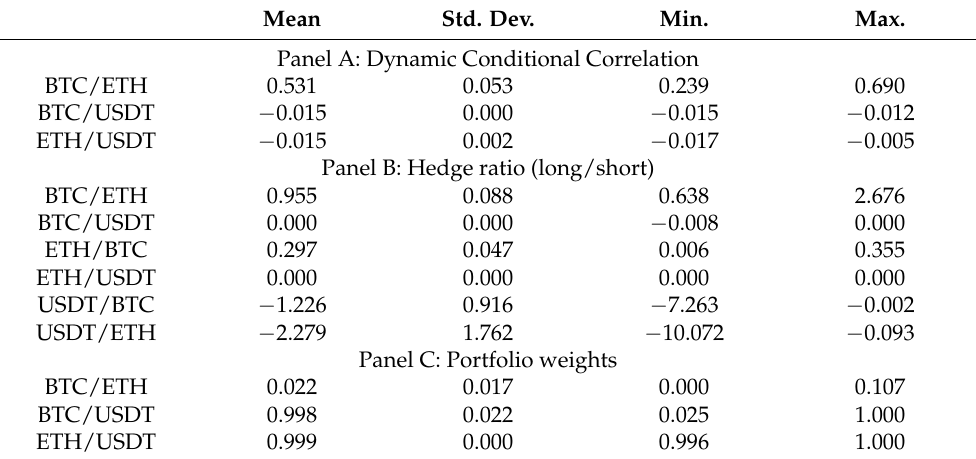
Figure 4. Dynamic conditional correlations (DCC Model). Table 6. Dynamic correlation summary statistics.